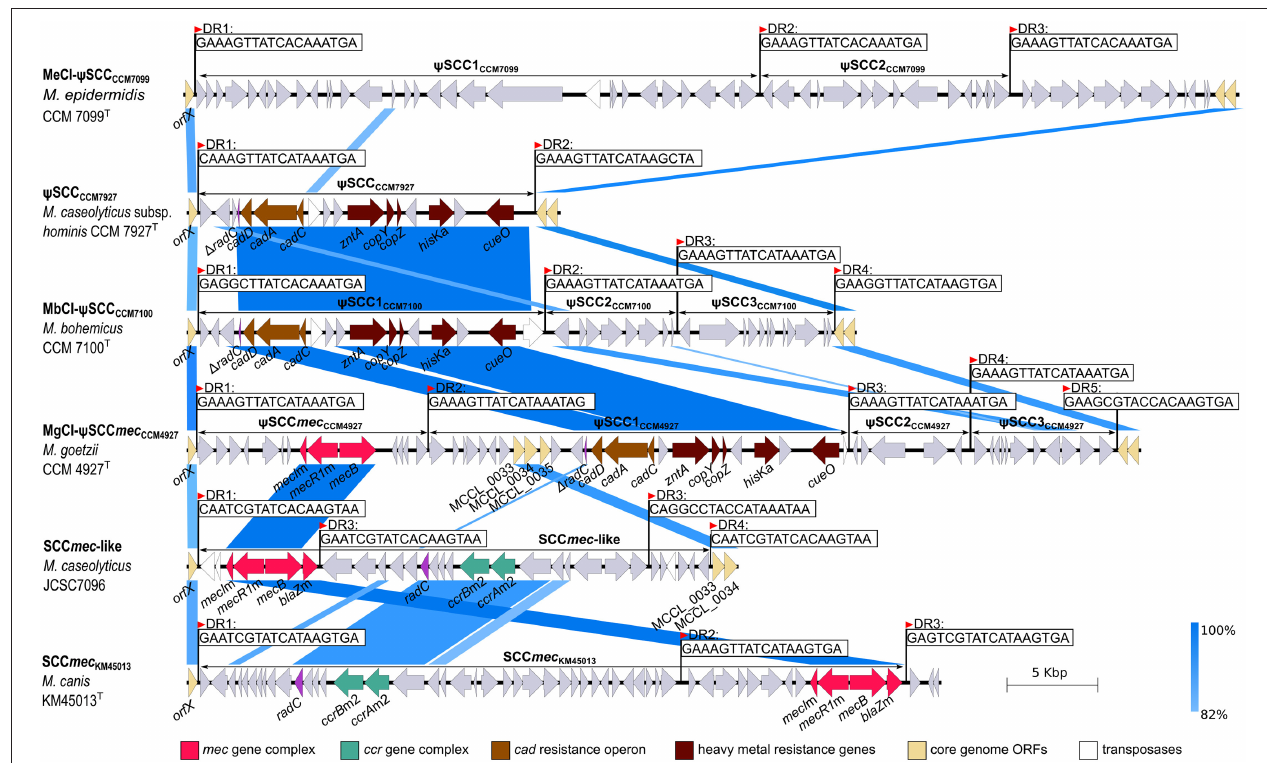
FIGURE 6 | Description and structural comparison of staphylococcal cassette chromosome (SCC)-like elements localized to oriC environs of Macrococcus caseolyticus subsp. hominis subsp. nov. CCM 7927 T , Macrococcus epidermidis sp. nov. CCM 7099 T , Macrococcus bohemicus sp. nov. CCM 7100 T , and Macrococcus goetzii sp. nov. CCM 4927 T with SCC mec elements in Macrococcus canis CCM 8748 T (GenBank accession number HG970732) and Macrococcus caseolyticus JCSC7096 (GenBank accession number AB498756). Direct repeats (DR) demarking the SCCs and related elements are shown. Arrows indicate ORFs and their orientation in the